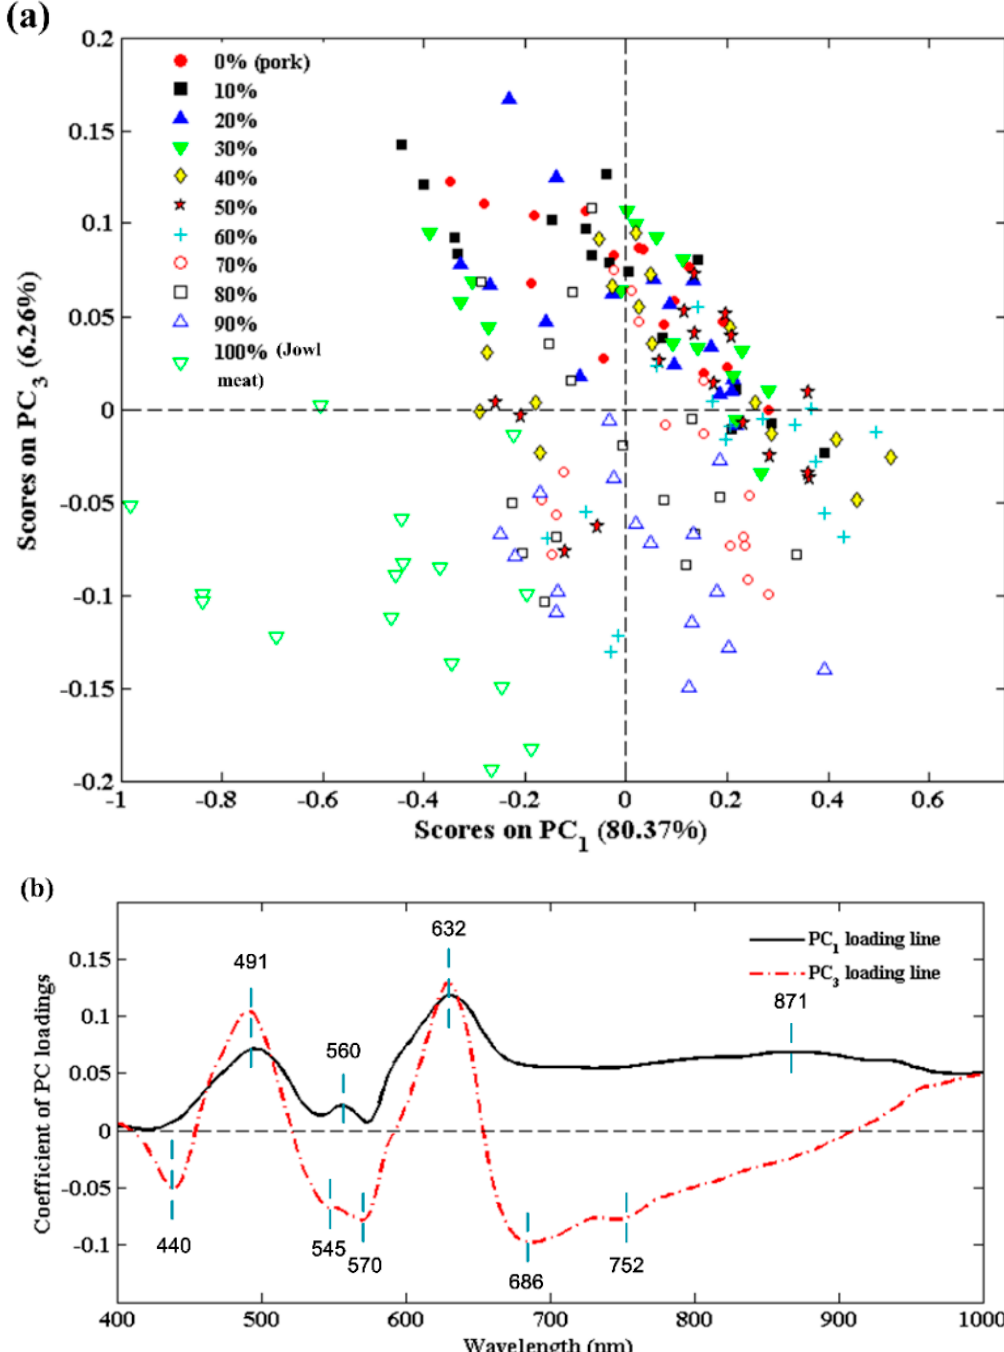
Figure 2. Analysis of effective PC scores and loadings. ( a ) PCA score plot of PC 1 vs. PC 3 , ( b ) Wavelength selection on PC 1 and PC 3 loading lines.